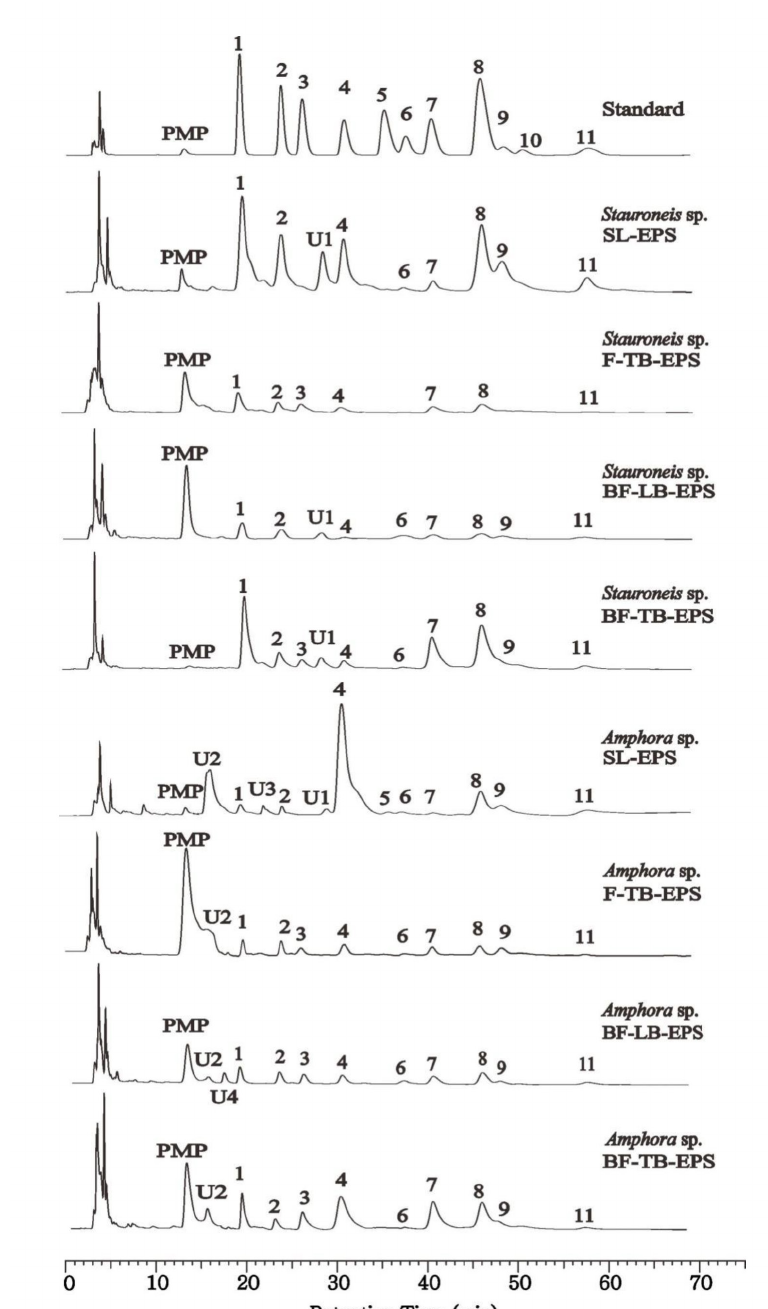
Figure 1 - The HPLC profiles of monosaccharides in different EPS fraction samples from two diatoms. Samples were analysed under the same HPLC conditions and labelled on top right of the obtained HPLC profiles. In sequence, peaks 1-11 represented the monosaccharides of Man, GlcN, Rha, Glc-A, Gal-A, Glc-NAC, Glc, Gal, Xyl, Ara, and Fuc, which were confirmed by comparing the retention times and UV profiles with those of the standards in the first HPLC profiles. Peaks U1-U4 were not matched with any of the 11 standards. Therefore, there were four unknown monosaccharides other than the 11 standards